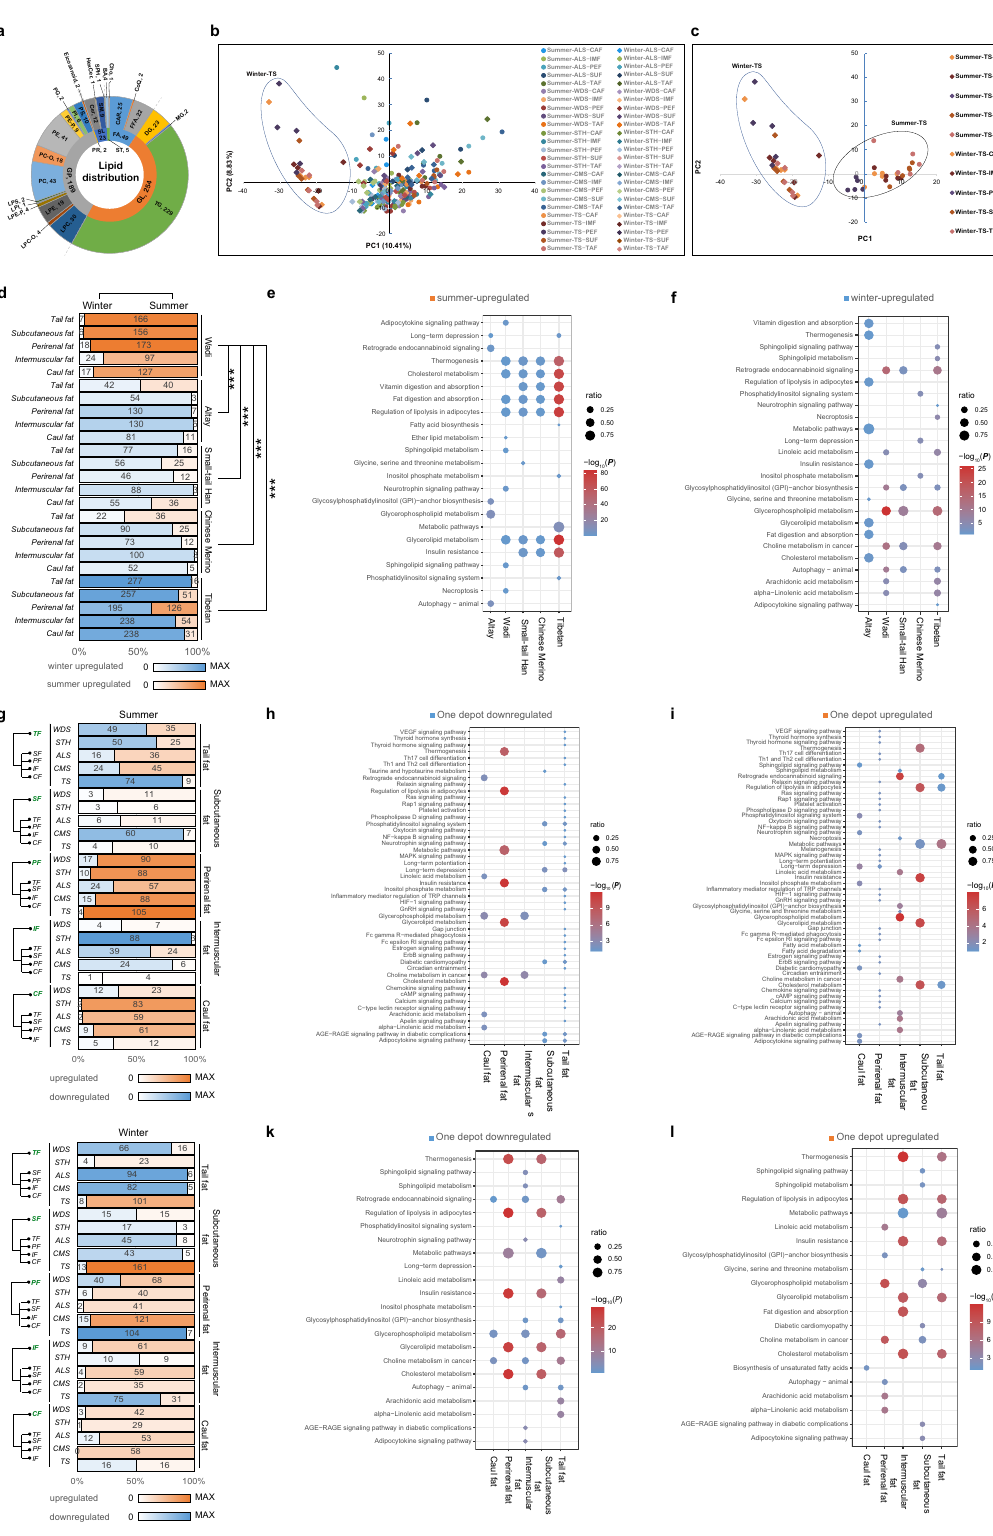
In the lipidomic analyses, we detected depot-speci fi c lipid abundance in different seasons by comparing one adipose tissue to the other four. In the summer samples, across all the comparisons among the fi ve adipose tissues in the fi ve populations, the range of signi fi cant differences in lipid abundance (VIP ≥ 1 and absolute log 2 FC (fold change) ≥ 1)